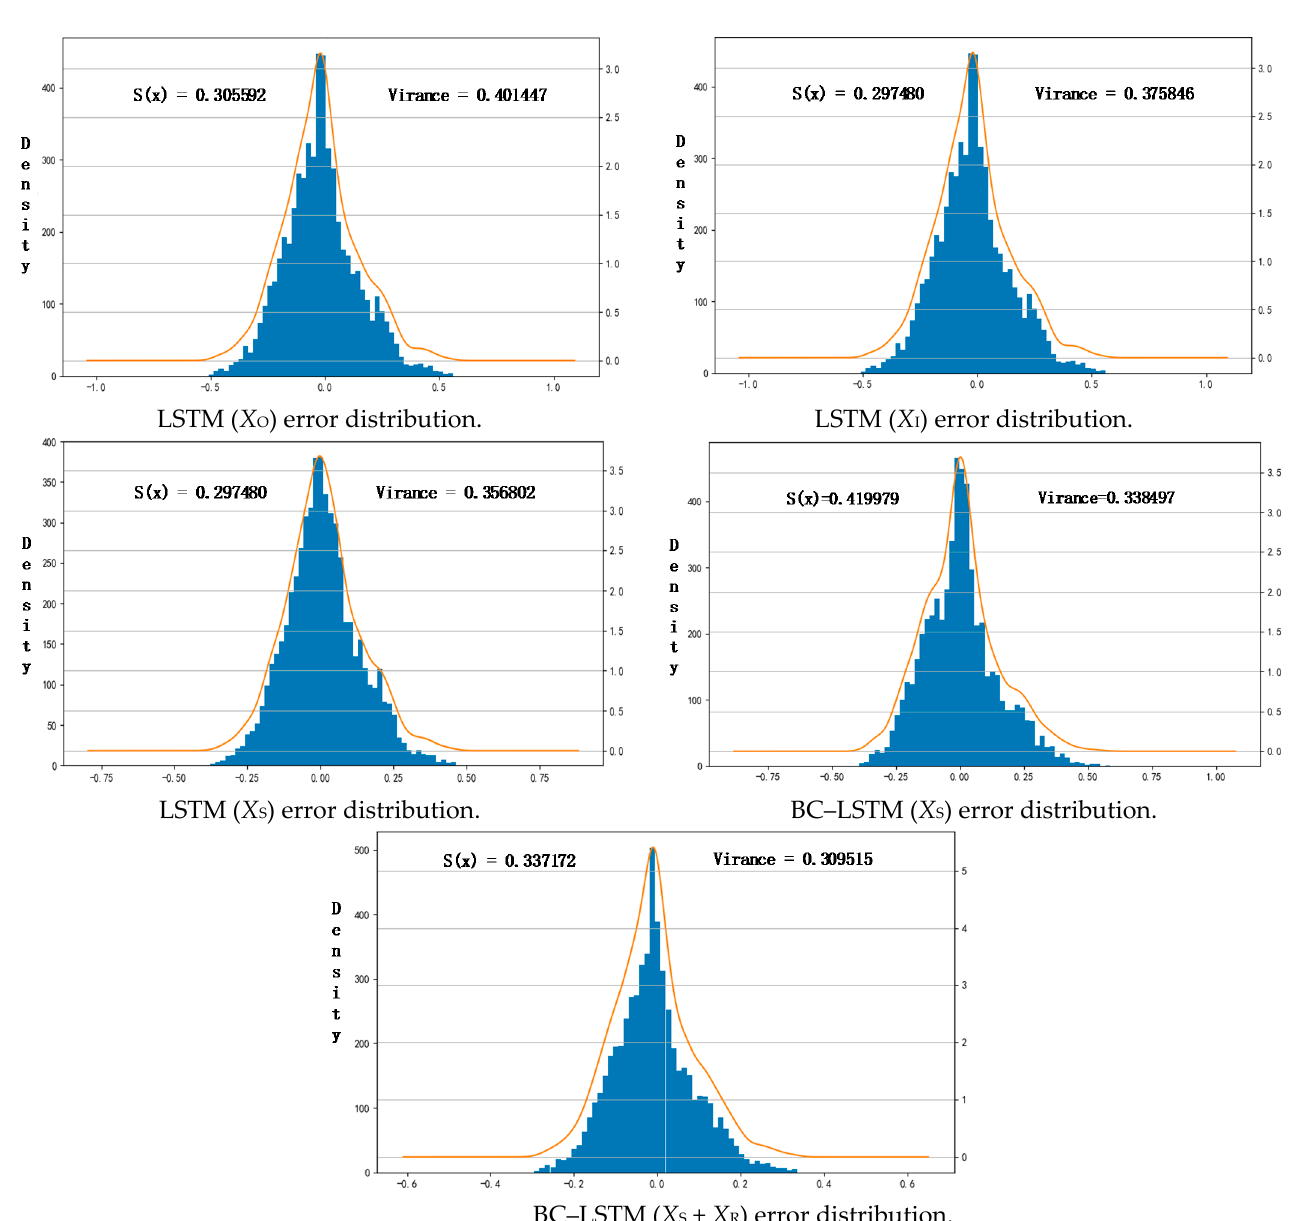
Figure 7. Error distributions: the blue histogram represents the error distribution, and the orange curve fits the error distribution. The smallest variance is given by the BC–LSTM ( X S + X R ), and the largest deviation is given by the BC–LSTM skewness.